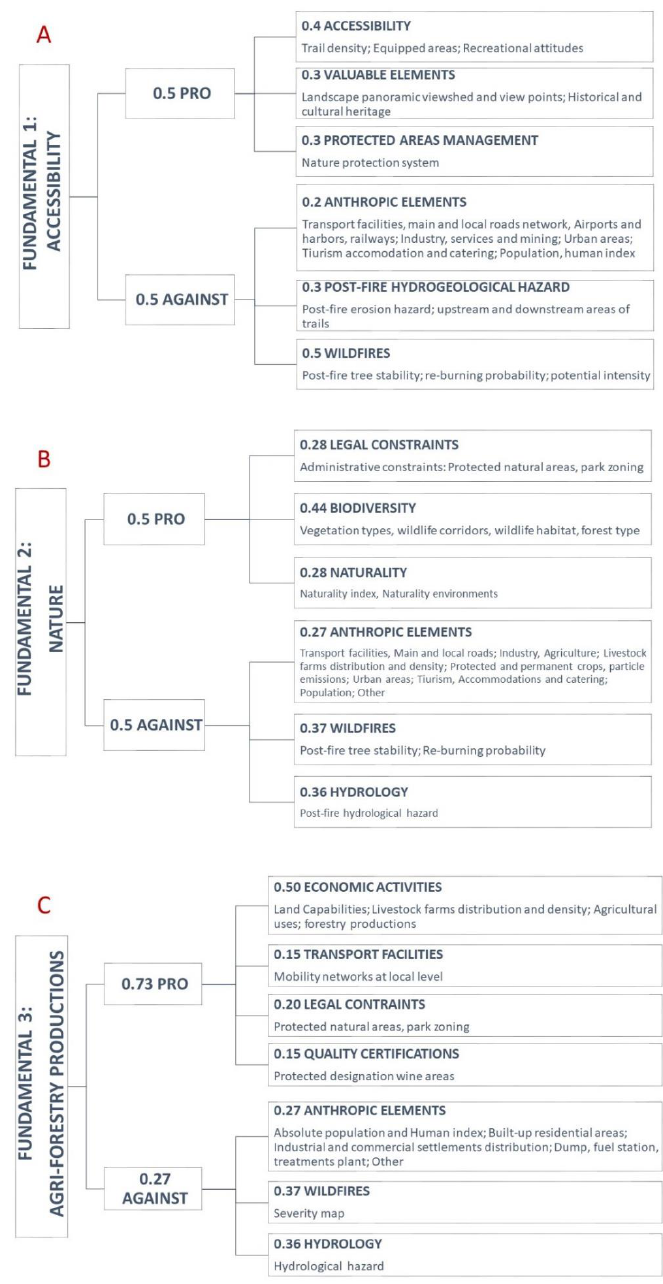
Figure 3. Criteria used for the objectives: ( A ). Accessibility; ( B ). Nature; ( C ). Agricultural and forestry production.